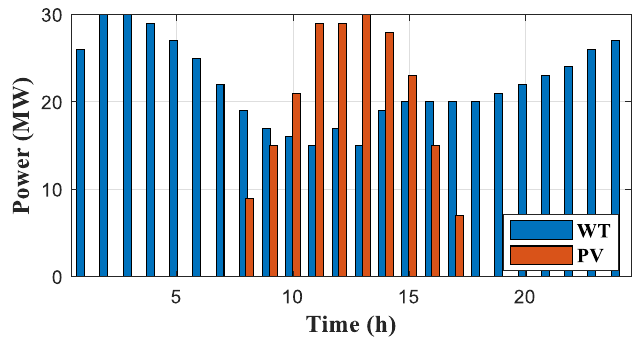
Figure 8. PV and WT power generation in 24 h.